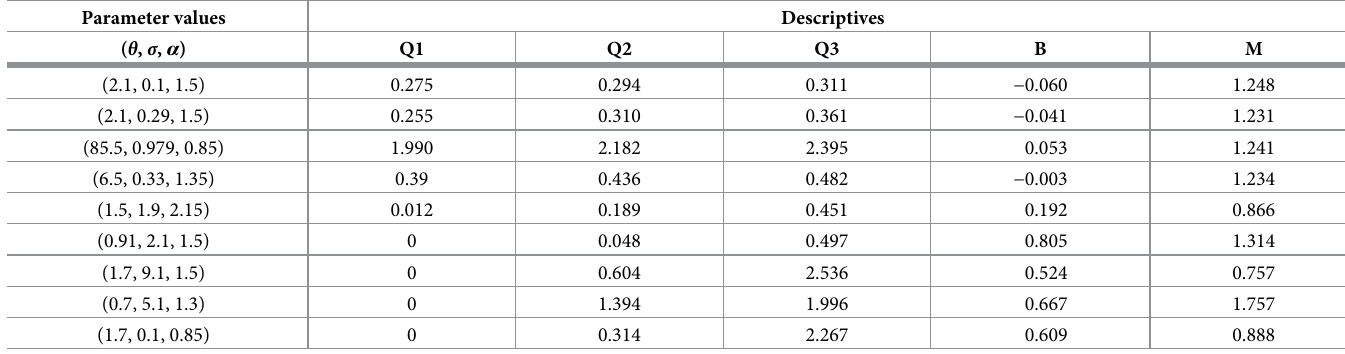
Table 2. Descriptive measures of EGuNH for some parameter values. Parameter values